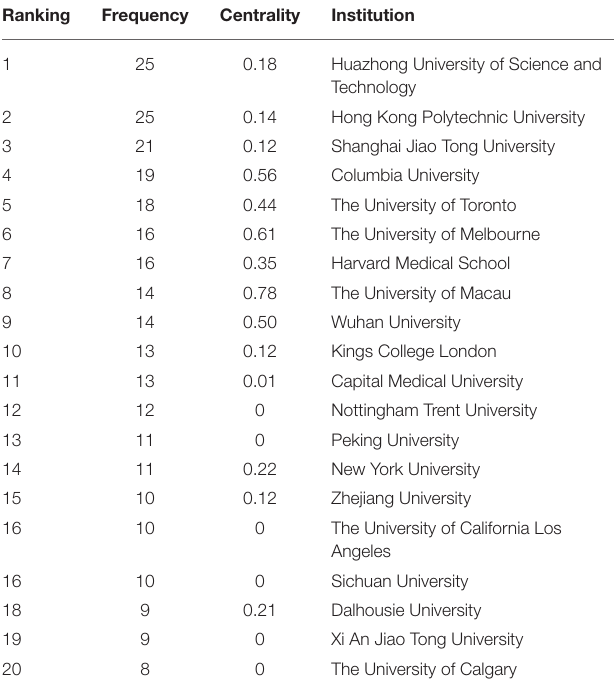
TABLE 3 | Top 20 institutions.